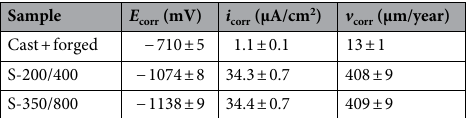
Table 2. Corrosion parameters calculated from Tafel